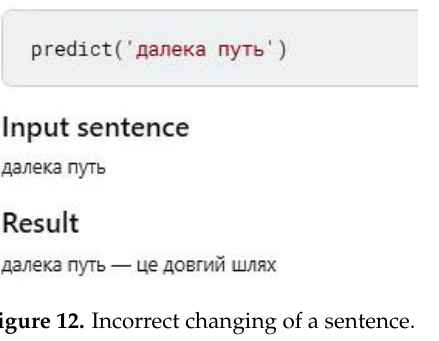
Figure 12. Incorrect changing of a sentence.